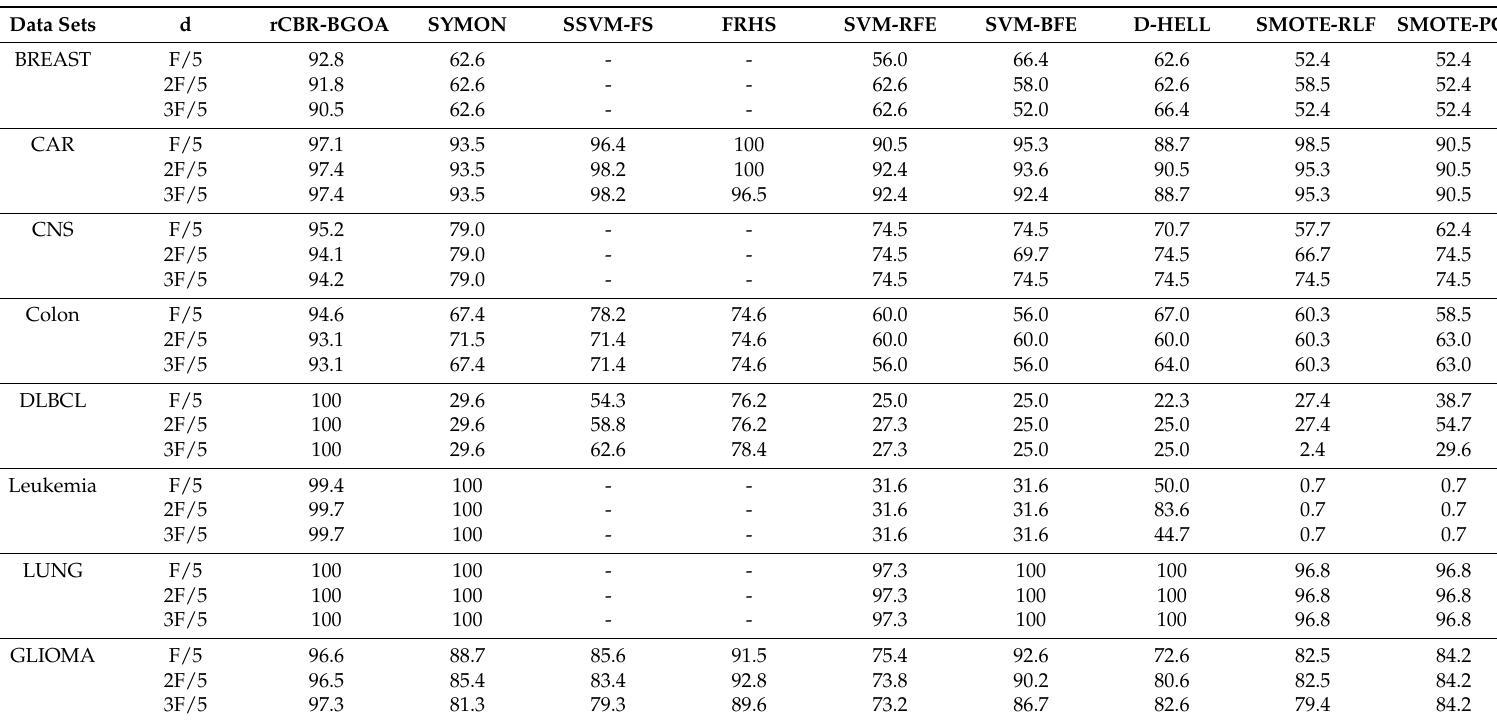
Table 4. Experimental results of rCBR-BGOA in comparison other methods on G-Mean metric. F/5, 2F/5, and 3F/5 are 20%, 40%, and 60% of the total features in F. Data